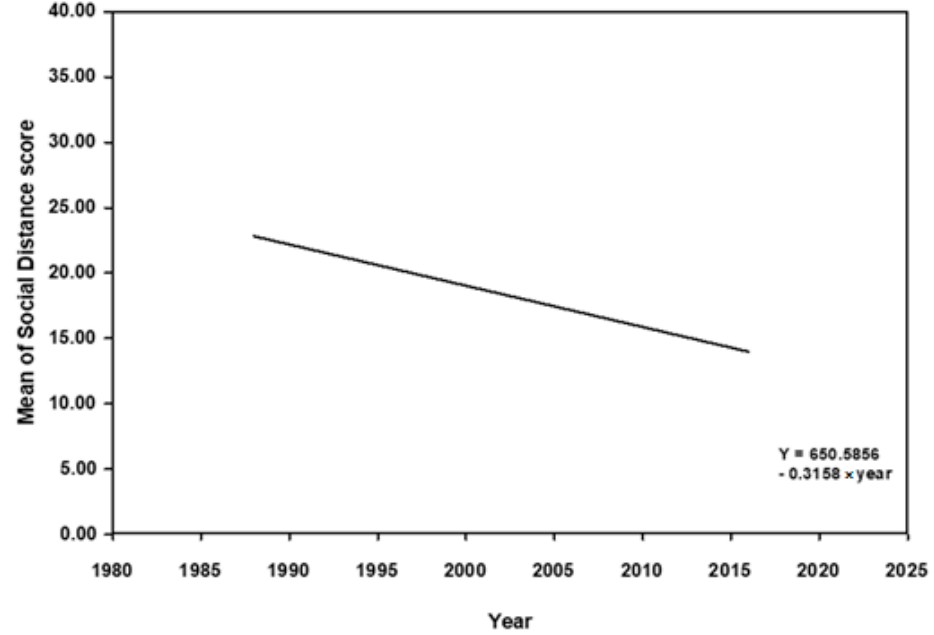
Figure 2. Meta regression of mean of Social Distance Scale score and year of data collection from 1988 to 2016.